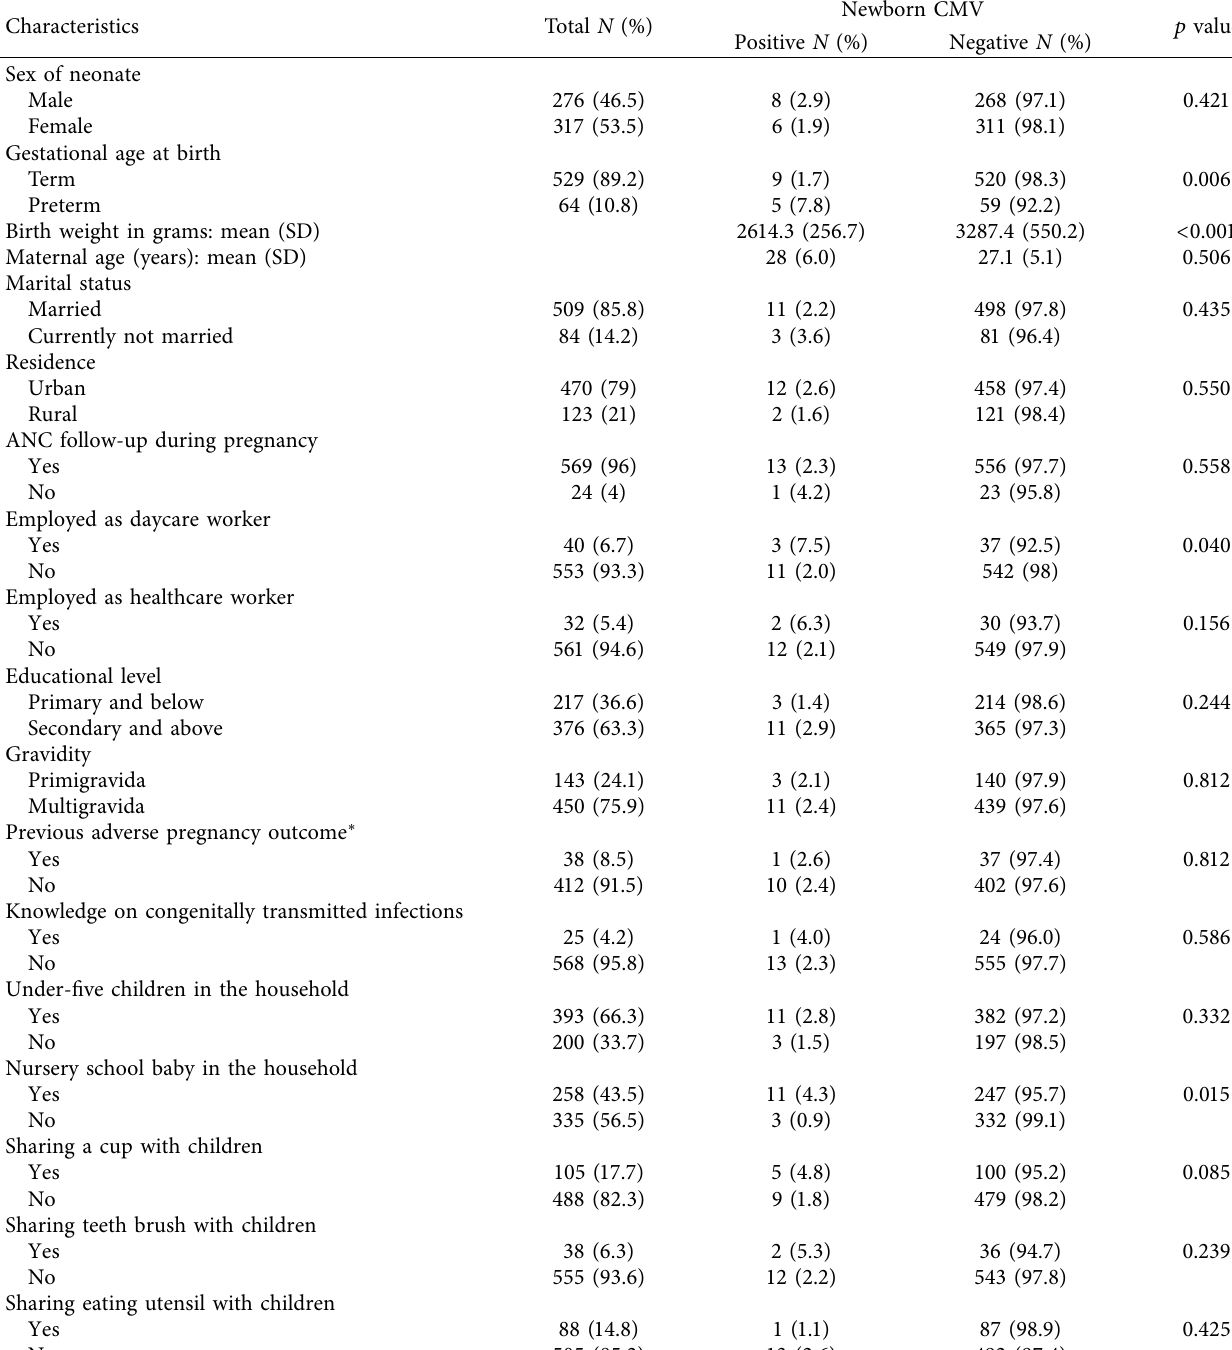
Table 1: Characteristics of mothers and newborns with congenital CMV